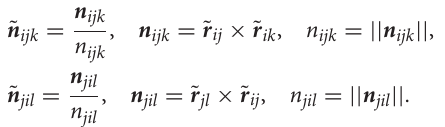
Frontiers in Materials |